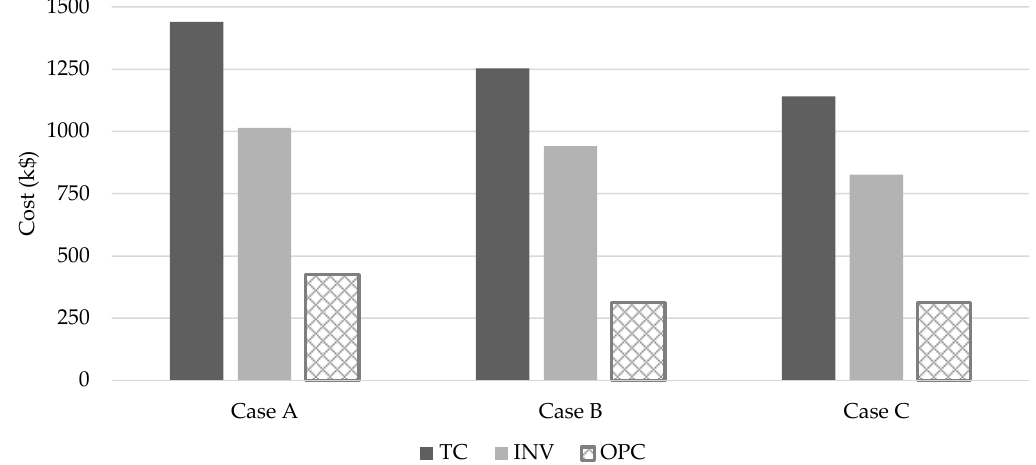
Figure 7. Total cost ( TC ), investment cost ( INV ), operational cost ( OPC ) for the planning solutions in Case A, Case B and Case C.